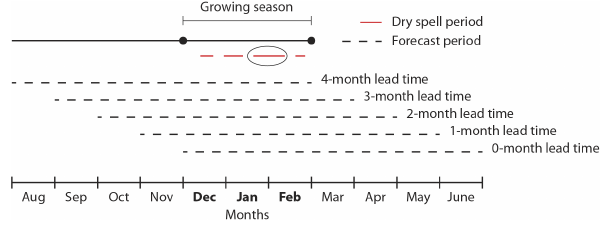
Figure 5. The timing of the growing season and lead times of sea- sonal forecasts. Evaluation of dry spells is performed in the growing season (see red